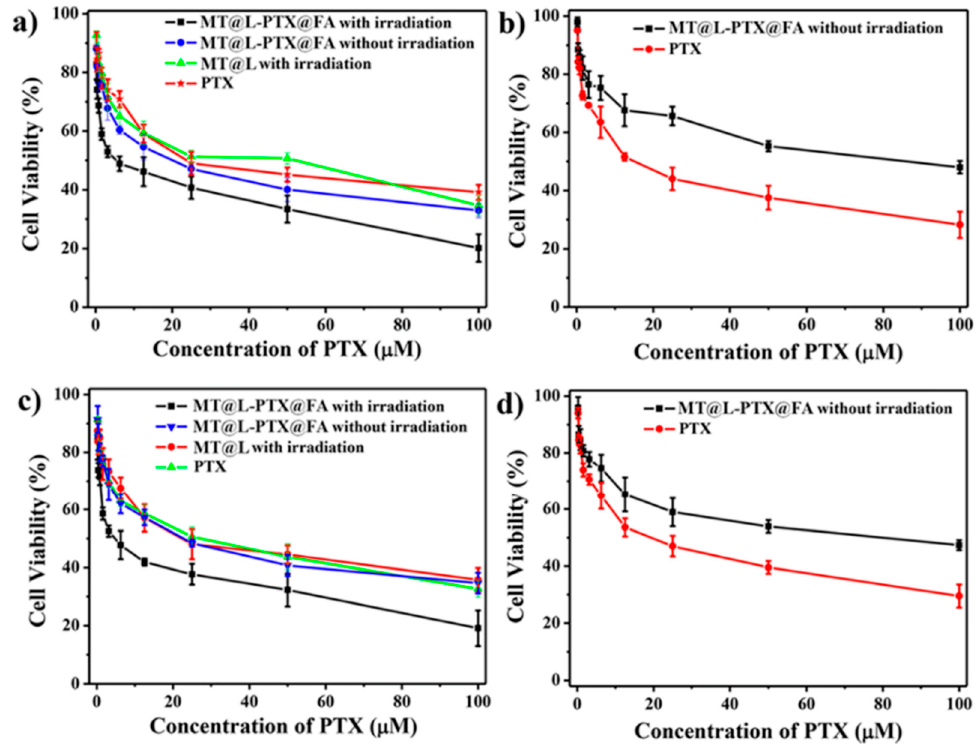
Figure 18. Experimental results showing the cytotoxicity of the hierarchical nanosystem consisting of Te NDs within Paclitaxel ‐ Loaded MgAl LDH gated mesoporous silica NPs towards ( a ) HepG2 cells, and ( c ) HeLa cells for 48 h with or without irradiation. Cytotoxicity of MT@L-PTX@FA without irradiation and free Paclitaxel on ( b ) HL7702 cells, and ( d ) 293T cells for 48 h. Reprinted with permission from Ref. [233]. Copyright (2019) American Chemical Society .